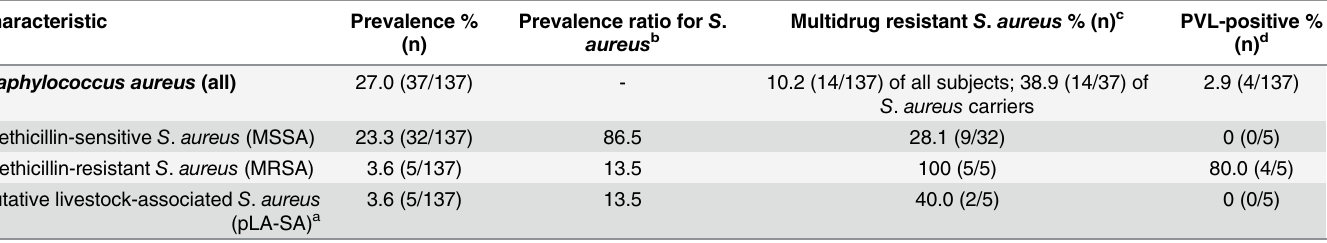
Table 2. Prevalence of Staphylococcus aureus nasal carriage, US beefpacking workers (n = 137). Characteristic